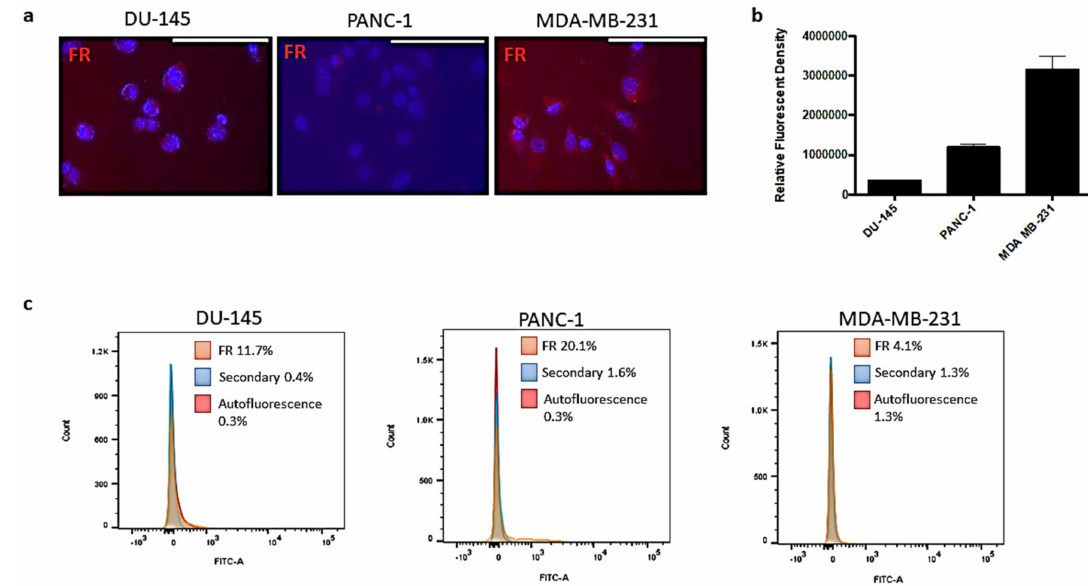
Figure 1. Folic acid receptor (FR) expression levels on DU-145 prostate, MDA-MB-231 breast and PANC1 pancreatic cancer cell lines. ( a ) Immunocytochemistry staining for FR in permeabilized DU-145, MDA-MB-231 and PANC-1 cells. The white scale bar represents 100 µ m. Pictures were taken at 400 × magnification. Blue DAPI stain represents the nuclei, and red staining is anti-FR antibody followed with AlexaFluor 594 secondary antibody for FR expression. ( b ) Quantification of expression levels by relative density corrected for average background staining of the AlexaFluor 594 secondary antibody. Error bar due to multiple images being quantified ( n = 3–4). The data are a combination of two independent experiments with similar results. ( c ) Flow cytometry was used to confirm the expression level of the FR. Graphs represent an overlay of FR, secondary only control, and autofluorescence